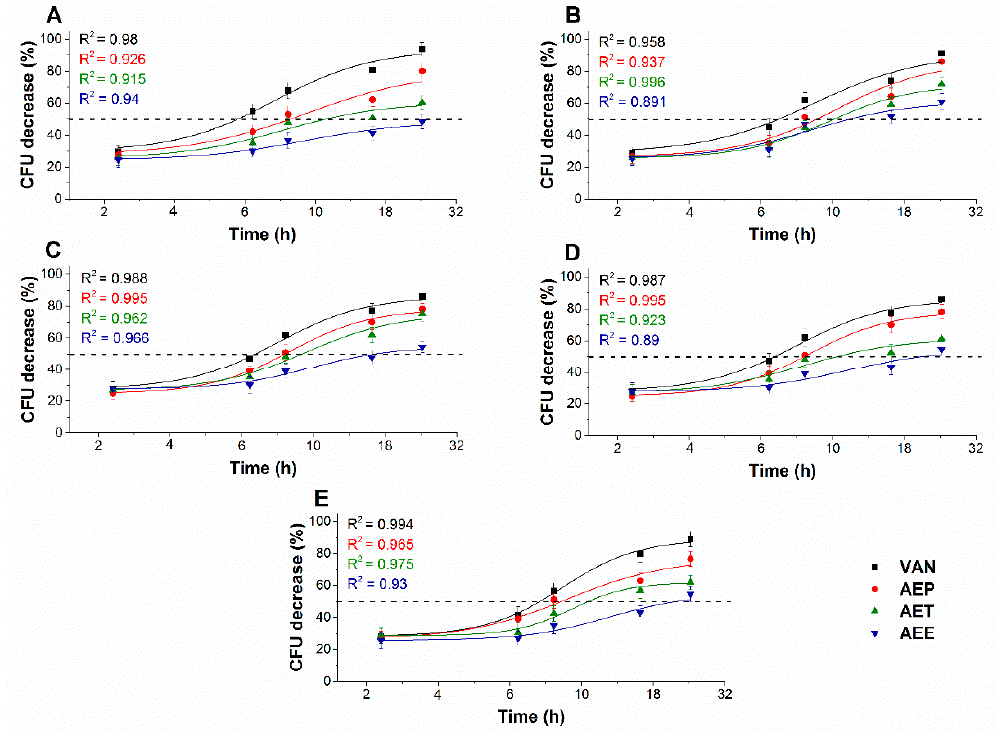
Figure 9. Effects of AEP, AET, and AEE at their MEC 10 concentrations on the mean percentage colony-forming unit (CFU / mL) decrement of the planktonic E. coli ( A ), S. aureus ( B ), B. subtilis ( C ), P. aeruginosa ( D ), and S. pyogenes ( E ) compared to their respective 0 h samples and vancomycin (VAN) standard antimicrobial controls after 2, 6, 8, 16 and 24 h of treatment (mean ± SD, n = 6 independent experiments each with three technical replicates).